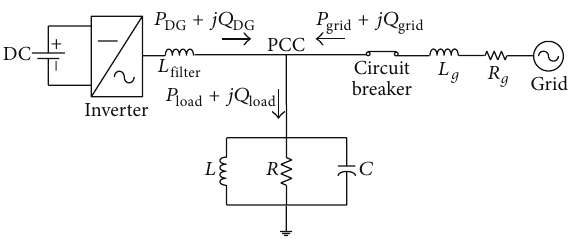
Figure 1: The recommended generic system for islanding